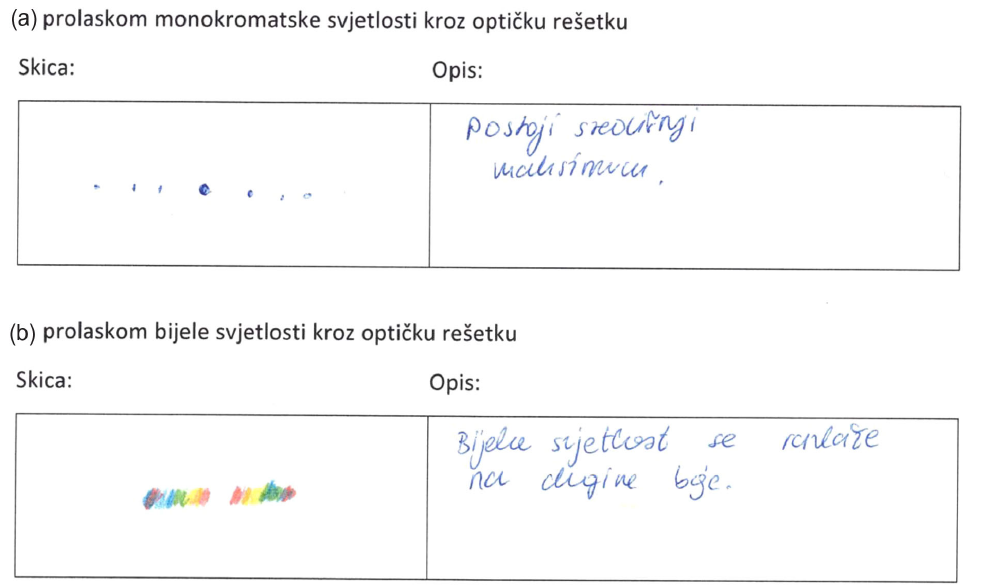
FIG. 2. An example of one student ’ s sketch and description for the pattern produced by passing monochromatic light through a diffraction grating ( “ there is a central maximum ” ) and by passing white light through a diffraction grating ( “ white light decomposes into rainbow colors ”